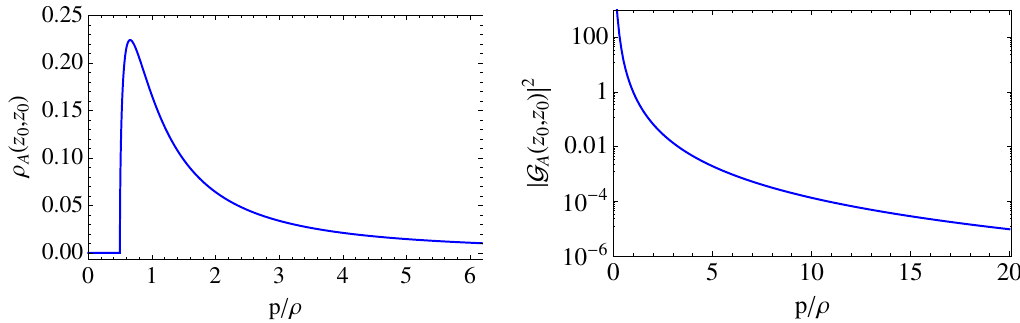
Figure 4 . Left panel: spectral density (cid:26) A ( z 0 ; z 0 ; p ) for a continuum gauge boson. Right panel: absolute value squared of the Green’s function, G A ( z 0 ; z 0 ; p ), for gauge bosons. We have used A 1 = 35 and c = 1 in both